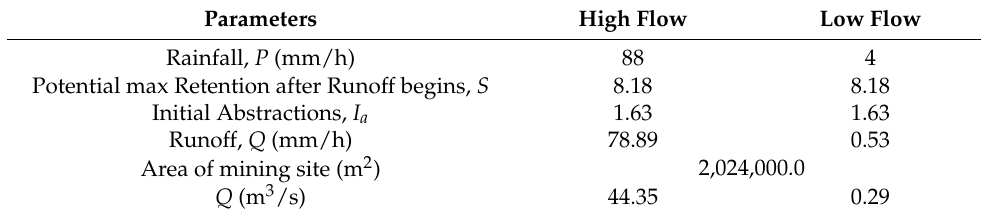
Table 3. Calculation of runoff for wet and dry